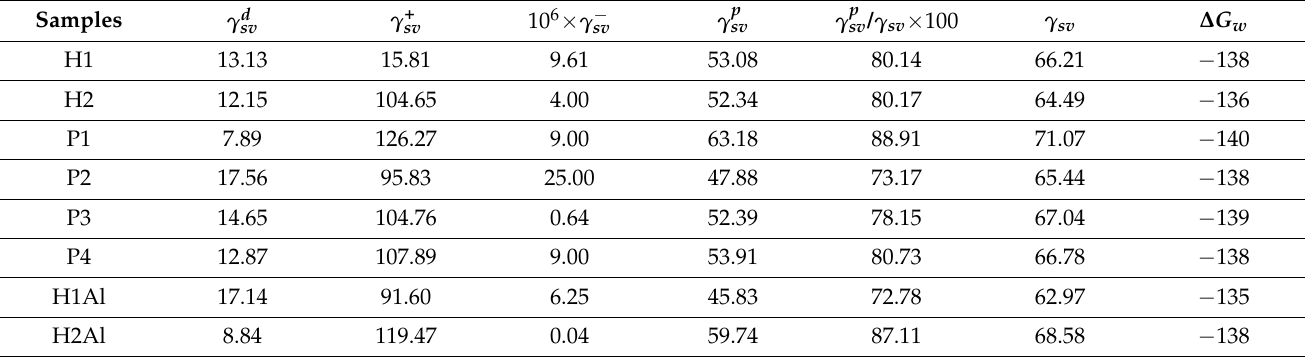
Table 3. Surface free energies and their components of dried formulations in